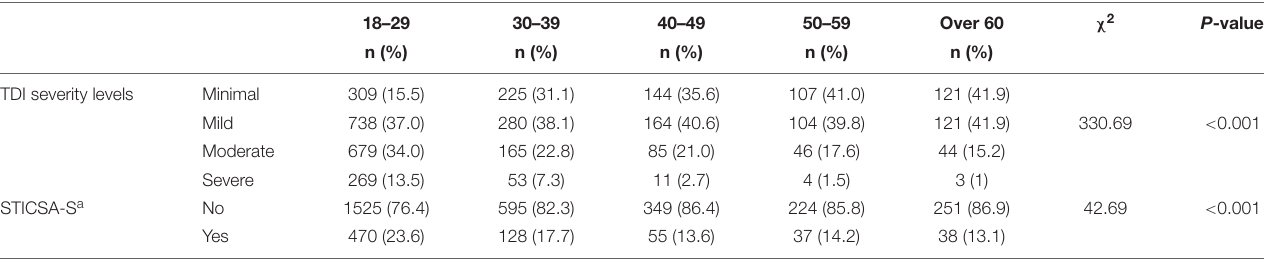
TABLE 3 | Prevalence of depressive severity levels, and state anxiety during the COVID-19 outbreak in the Italian population stratified by age groups ( N =